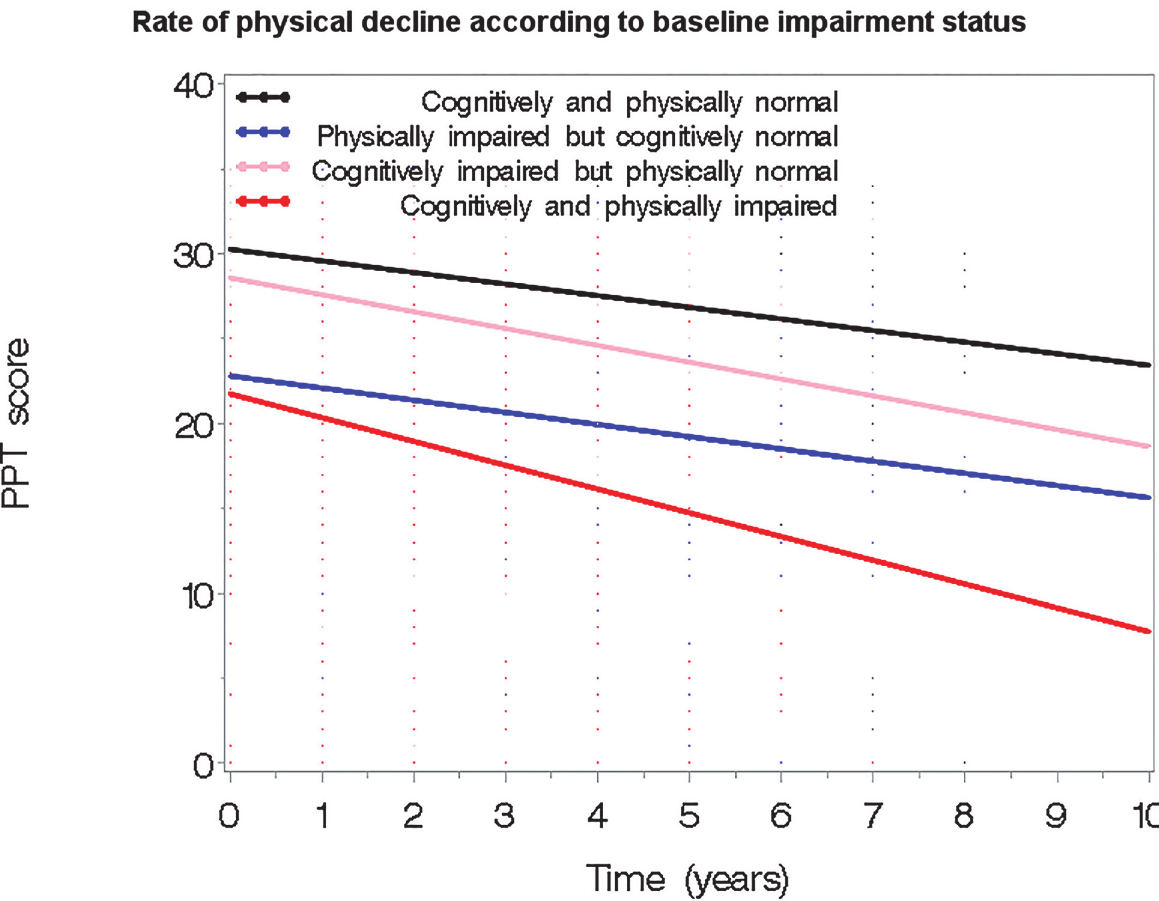
Fig 1. Rate of physical functional decline based on baseline cognitive/physical impairment status. Significantly steeper decline in physical performance (measured with PPT score) was noted in the CI and CPI groups, although physical impairment does not add much above what is seen in the CI group. In contrast, the PI group appears to decline in physical functionality at similar rates with the NI. Results are from the full model adjusted for age, gender, education, race and baseline physical